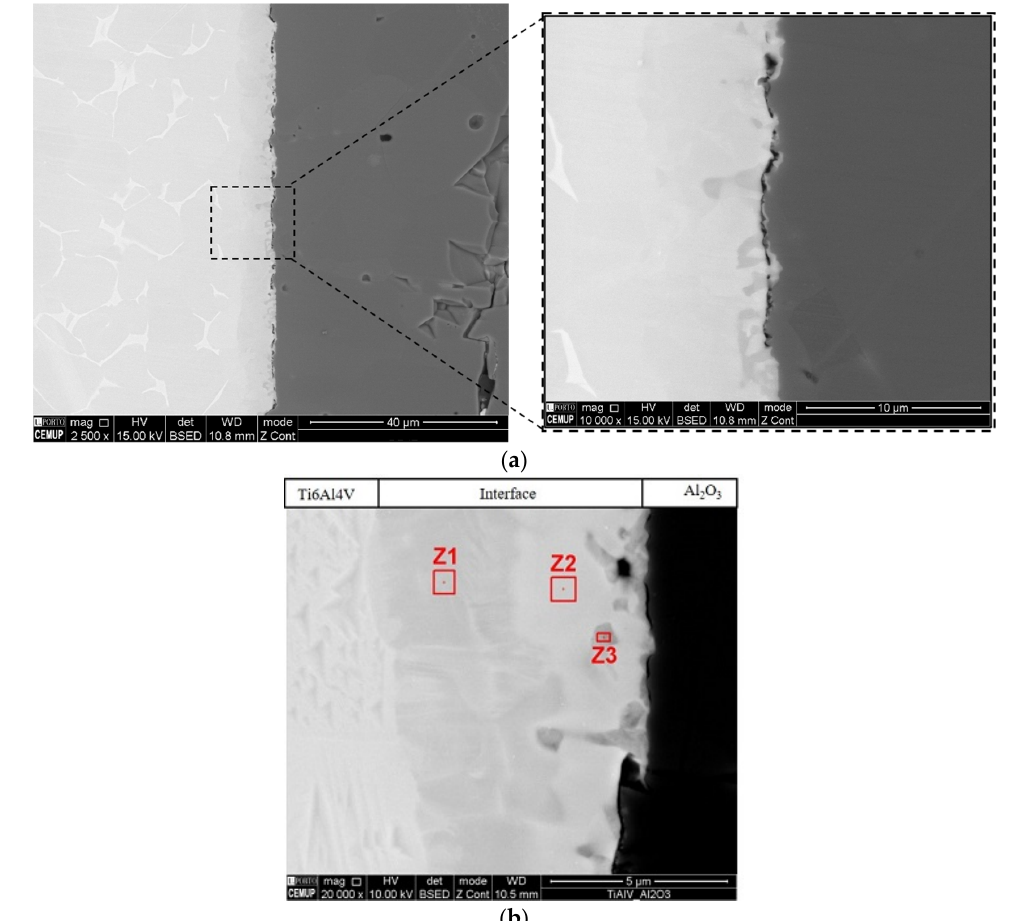
Figure 4. SEM images of the joints without interlayer processed at ( a ) 1000 °C for 60 min and ( b ) 1000 °C for 10 min.